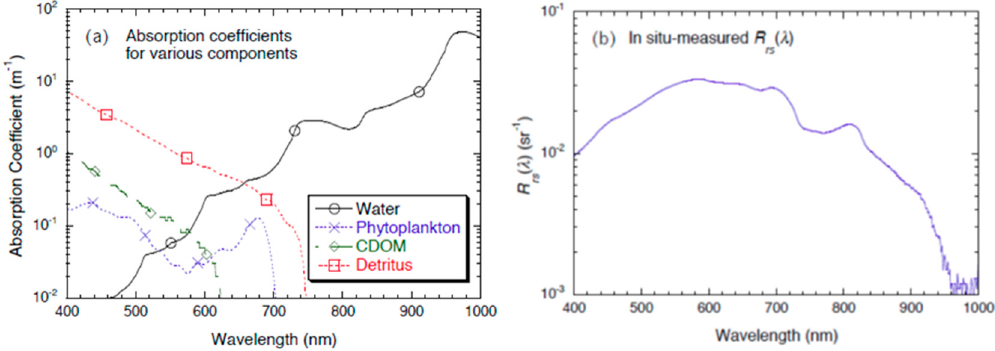
Figure 2. In situ measurements of (a) a ph ( λ ), a d ( λ ), and a g ( λ ) and (b) remote sensing reflectance R rs ( λ ) at the location [31.387 ◦ N, 120.267 ◦ E] measured at 13:10 PM local time on 7 January 2007 in Lake Taihu. The corresponding Chl-a and total suspended matter (TSM) were 14.5 mg m − 3 and 90.30 g m − 3 , respectively.